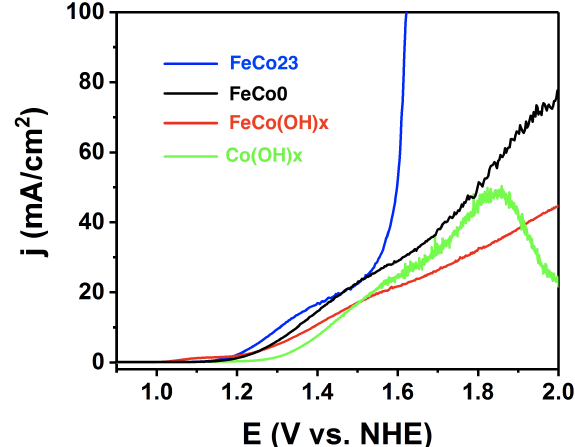
Figure 3. Comparative linear sweep voltammetry (1 mV/s) for the FeCo23 compared with the related oxo-hydroxides. Electrolyte: 0.1 M KPi + 1 M KNO 3 , pH =